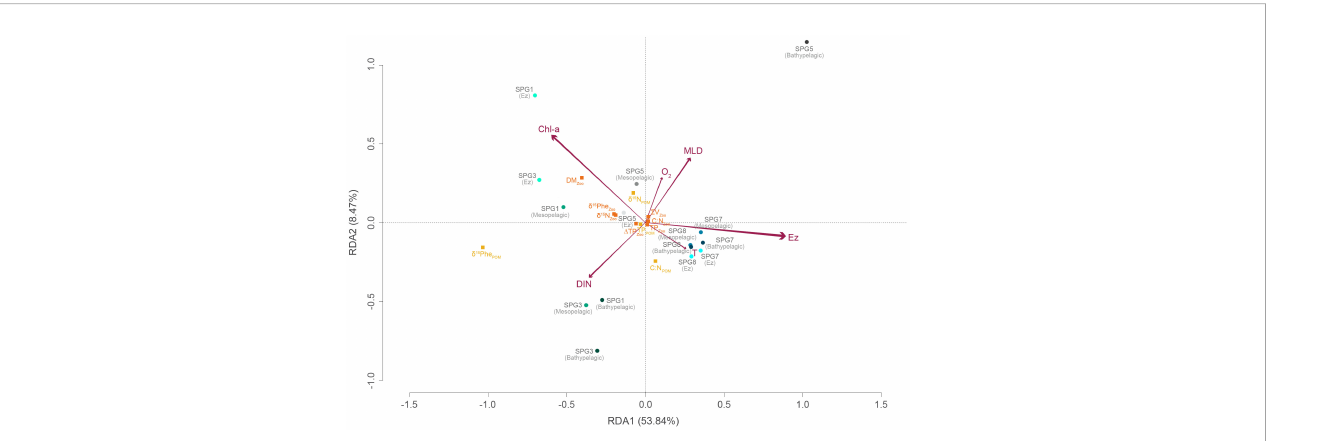
FIGURE 7 Redundancy analysis (RDA) triplot ordination with various ecological indices of seston and zooplankton as variable responses (yellow and orange squares, respectively) against selected environmental variables (arrows) on 5 stations and 3 depth strata (circles) studied across the longitudinal transect in the Southeast Paci fi c. The explanatory (environmental) variables are labeled as follows: chlorophyll-a, Chl-a; dissolved inorganic nitrogen concentration, DIN; temperature, T; euphotic zone, Ez; mixed layer depth, MLD; dissolved oxygen concentration, O 2 . The length of the arrows indicate the strength of the explanatory variable to drive variation in the community matrix. The fi rst two canonical axes explain 62.3 % of variability ( F = 3.02, P value = 0.028, R 2 =